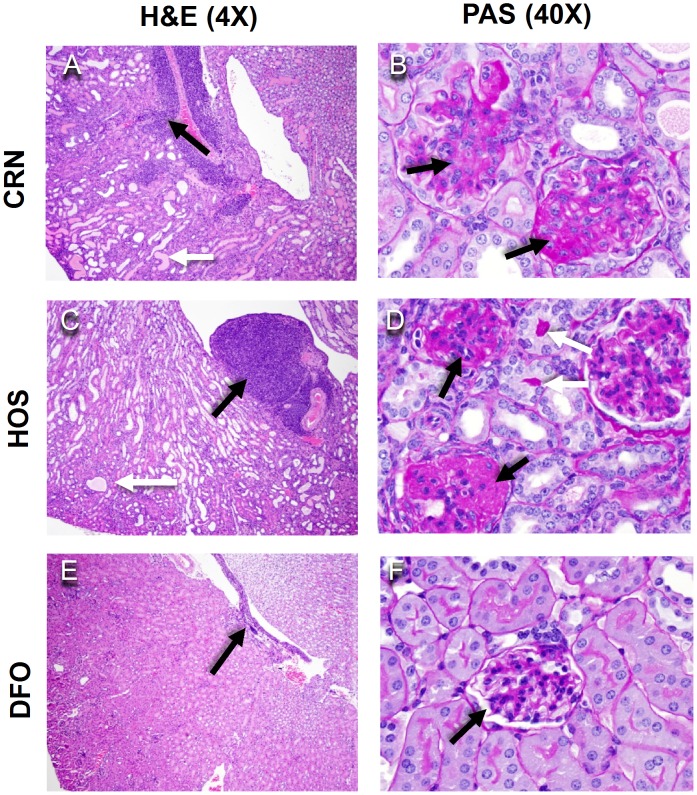
n-3 PUFA consumption attenuates glomerulonephritis.Female NZBWF1/J mice were fed CRN, HOS, or DFO diets for 30 wk beginning at 4 wk. At wk 34, renal histopathology was assessed. Panels A, C and F show representative hematoxylin and eosin (H&E)-stained sections (4X). Note the variable degree of tubular dilation and proteinosis (white arrow) and lymphocyte infiltration at the pelvis (black arrows). Panels B, D and F depict Periodic Acid-Schiff (PAS)-stained sections (40X). Note the tubular proteinosis (white arrows) and the thickened tubular basement membrane and mesangial cell hyperplasia-related glomerular hypercellularity with extensive adhesions to the Bowman’s capsule (black arrows). Lesions were moderate to severe in mice fed CRN and HOS diets and were mild in the mice fed DFO diet.